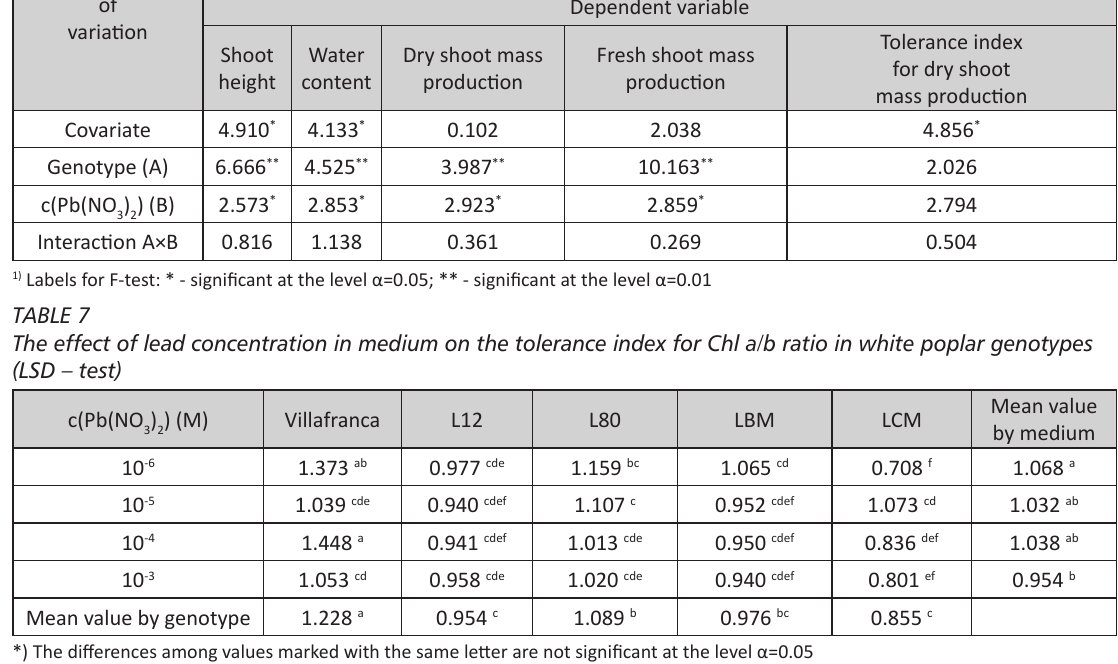
*) The differences among values marked with the same letter are not significant at the level α=0.05